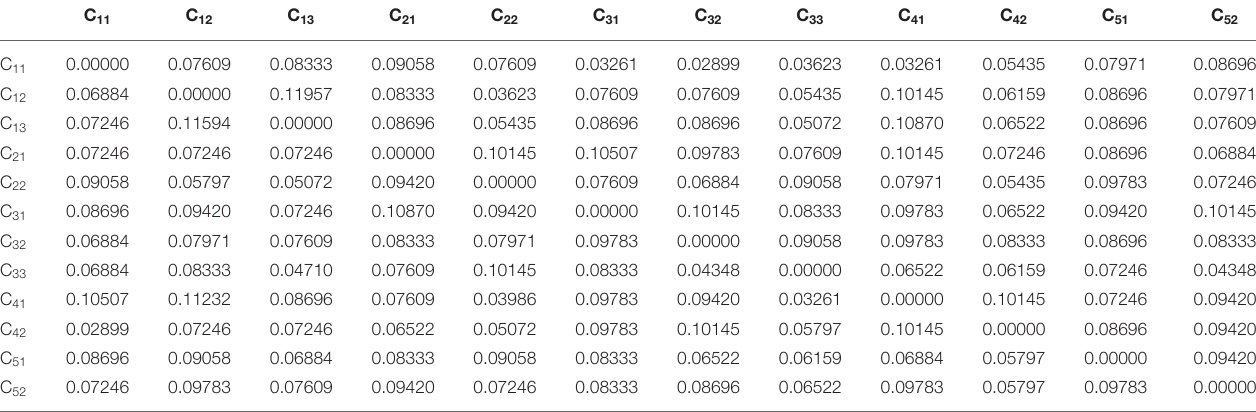
TABLE 3 | Initial direct relationship matrix D